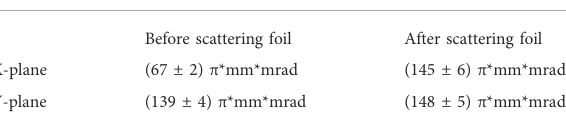
TABLE 1 Measured emittance values just before and after the scattering